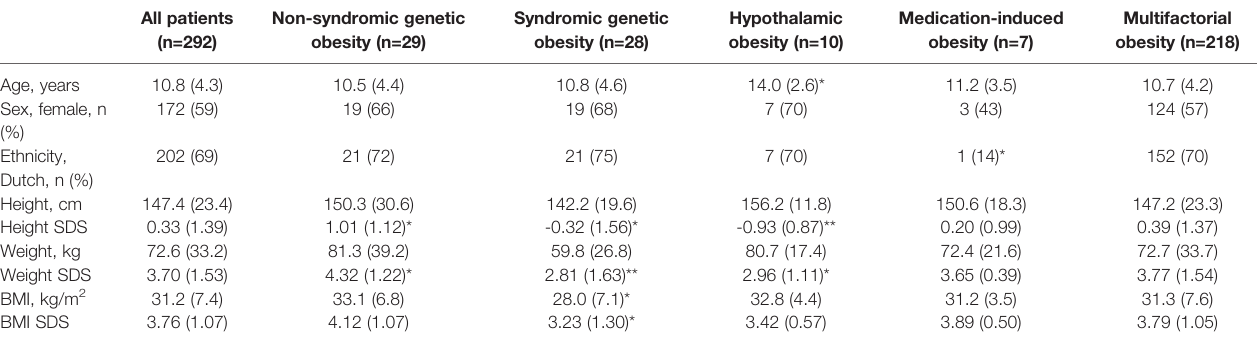
TABLE 2 | Baseline characteristics of the study population. All patients (n=292)